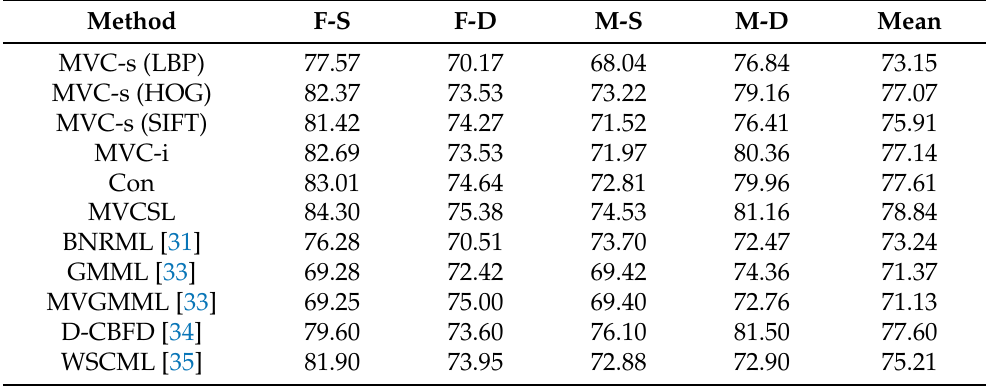
Table 3. Comparisons of mean verification accuracy (%) on the KinFaceW-I dataset under the image-restricted